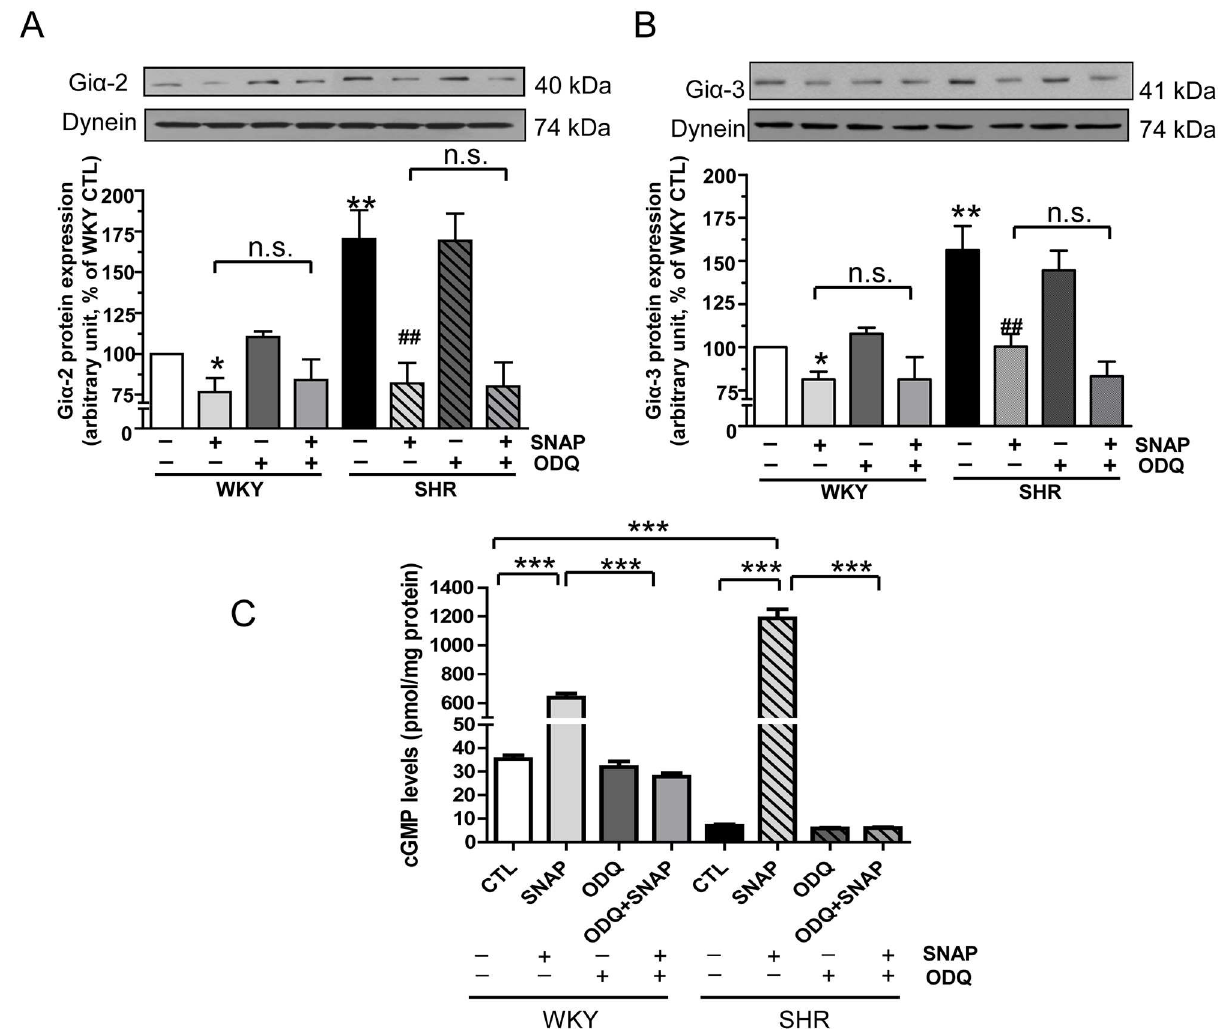
Fig 3. (A and B) Effect of ODQ on SNAP- induced decreasedexpression of Gi α proteins (A and B) in aortic vascularsmooth muscle cells (VSMCs) from 12-weekold SHR and age-matched WKY rats. ConfluentVSMC were incubatedin the absence(control) or presence of 1H-(1, 2, 4) oxadiazolo [4, 3-a] quinoxalin-1-one(ODQ), for 30 mins prior to the treatment with SNAP for 24 h. The cell lysates were preparedand subjectedto Western blot analysisusing specific antibodiesagainstGi α -2(A) and Gi α -3(B) or dyneinas loadingcontrol upper panel)as describedin the Materials and methods. Quantification of protein bands was done by densitometric scanning(lower panel). The results are expressedas a percentage of the WKY control (CTL), taken as 100%. Values are the mean ± SD of 4 separate experiments using different cell populationsfrom different animals. * P < 0.05, ** P < 0.01vs WKY CTL group; ## P < 0.01 vs SHR CTL group. NS, Not significant.(C) Effect of ODQ on SNAP- induced increased levels of cGMP in aortic vascularsmooth muscle cells (VSMCs) from